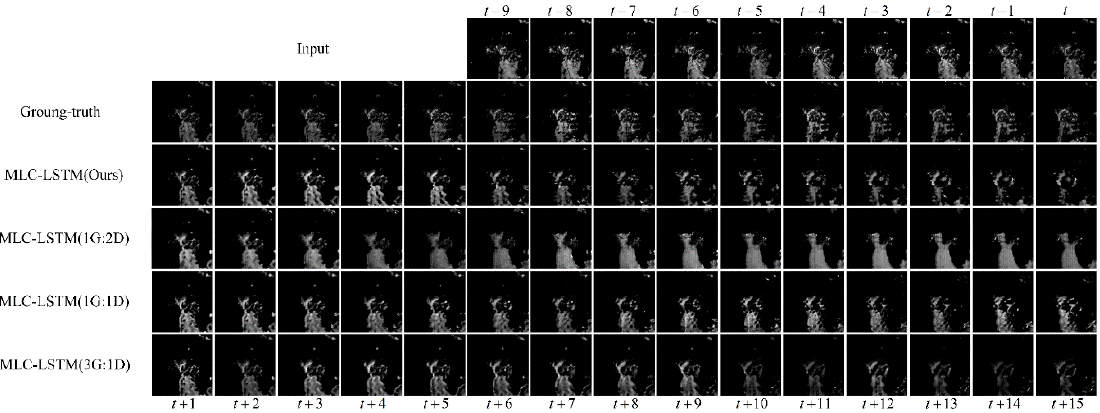
Figure 7. The extrapolation results for echo at Hangzhou, China, 8 August 2016, 23:07 UTC. The last five rows show the results obtained by MLC-LSTM trained with different loss schemes, respectively.